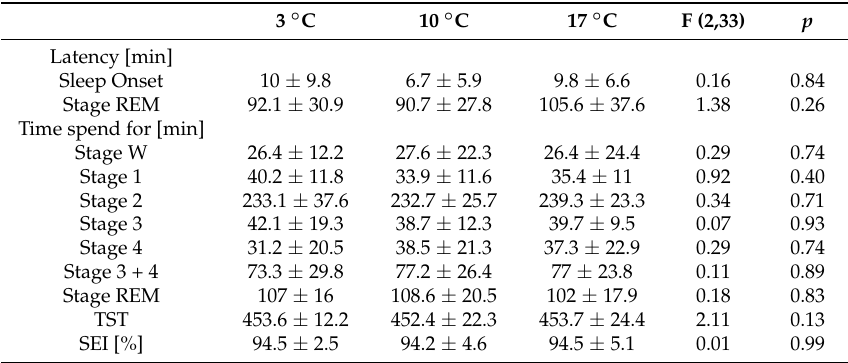
Table 1. Sleep parameters under 3 ◦ C, 10 ◦ C and 17 ◦ C. Results are shown as the average ± SD.